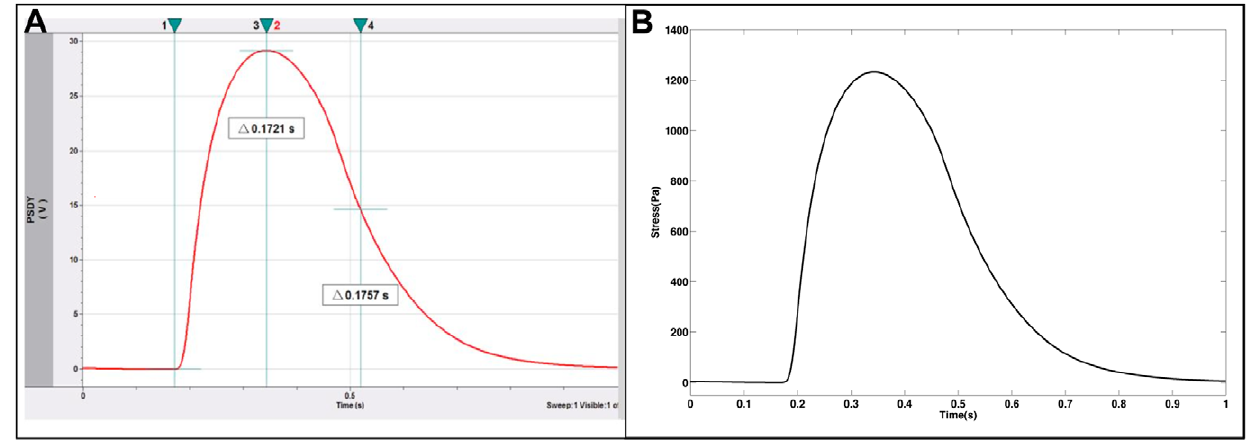
Figure 8. Contraction kinetics from muscle tissue cultured in NbActiv4 media. A) raw data recorded from Bio-MEMS device showing TPT and K RT, B) Stress values calculated using the modified Stoney’s equation.